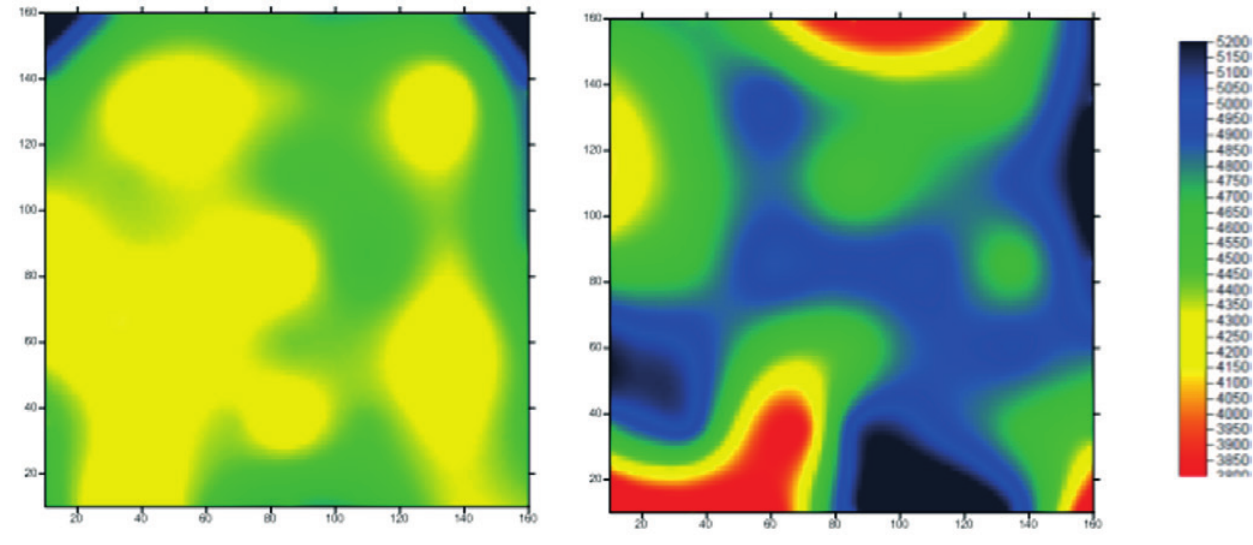
(a) images generated from the wall, with experienced operator (B) images generated from the wall with operator training